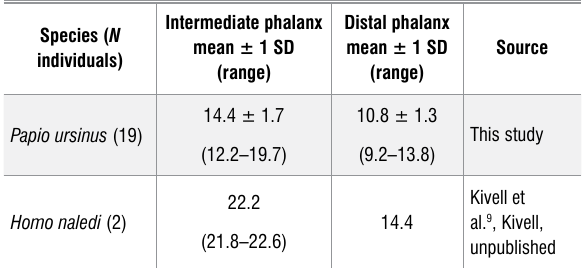
Lengths (in mm) of the third intermediate and distal phalanx of the hand. Most measures of Papio ursinus were obtained from specimens in the School of Anatomical Sciences, University of the Witwatersrand (see Supplementary table 1 for catalogue